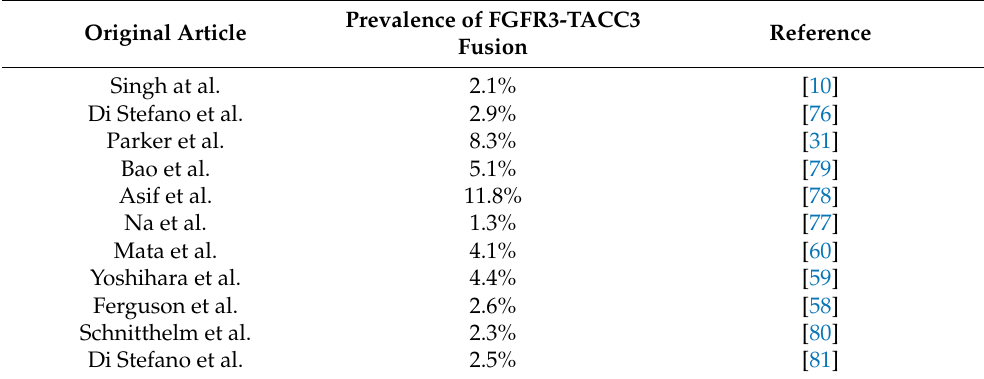
Table 1. Reported prevalence of FGFR3-TACC3 in human